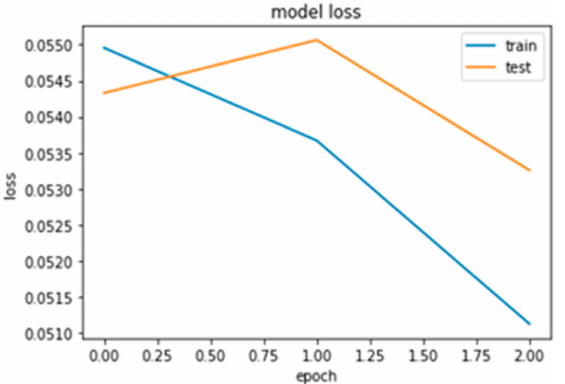
Figure 10. Loss function